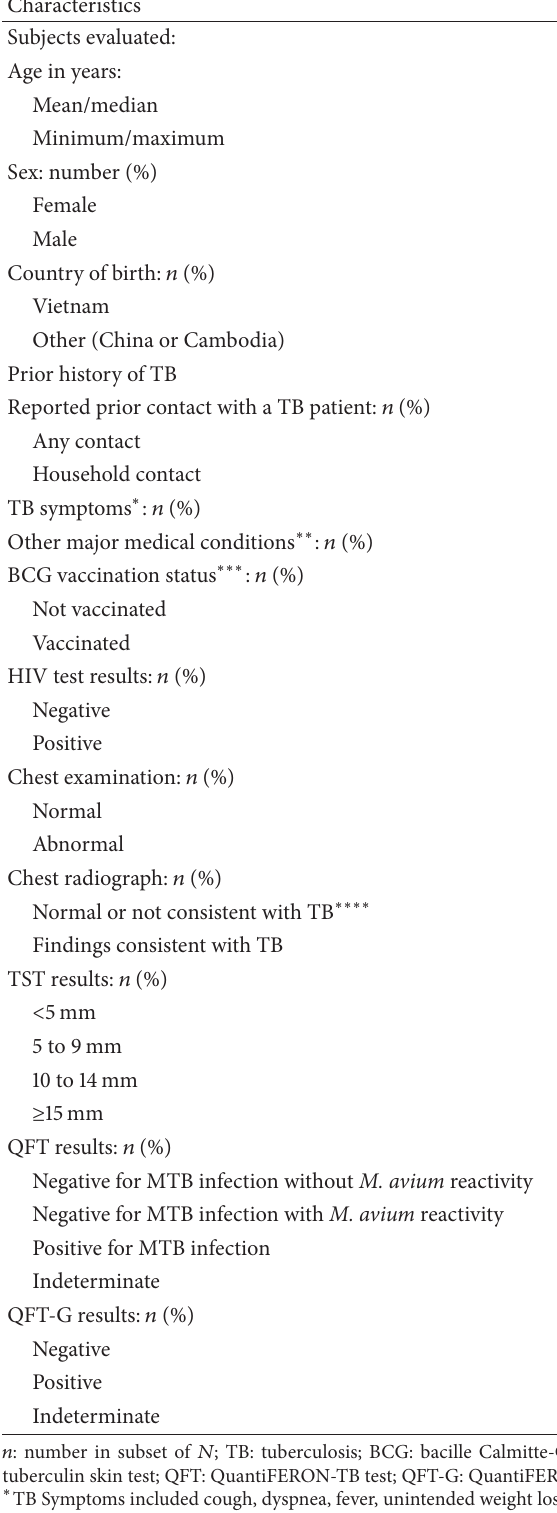
Table 1: Subject characteristics and test results of US-bound immigrant visa applicants in Vietnam.